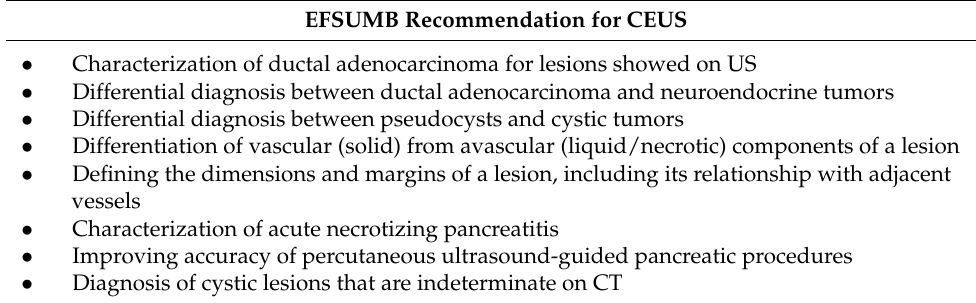
Table 1. EFSUMB Recommendation for studying focal pancreatic lesion on